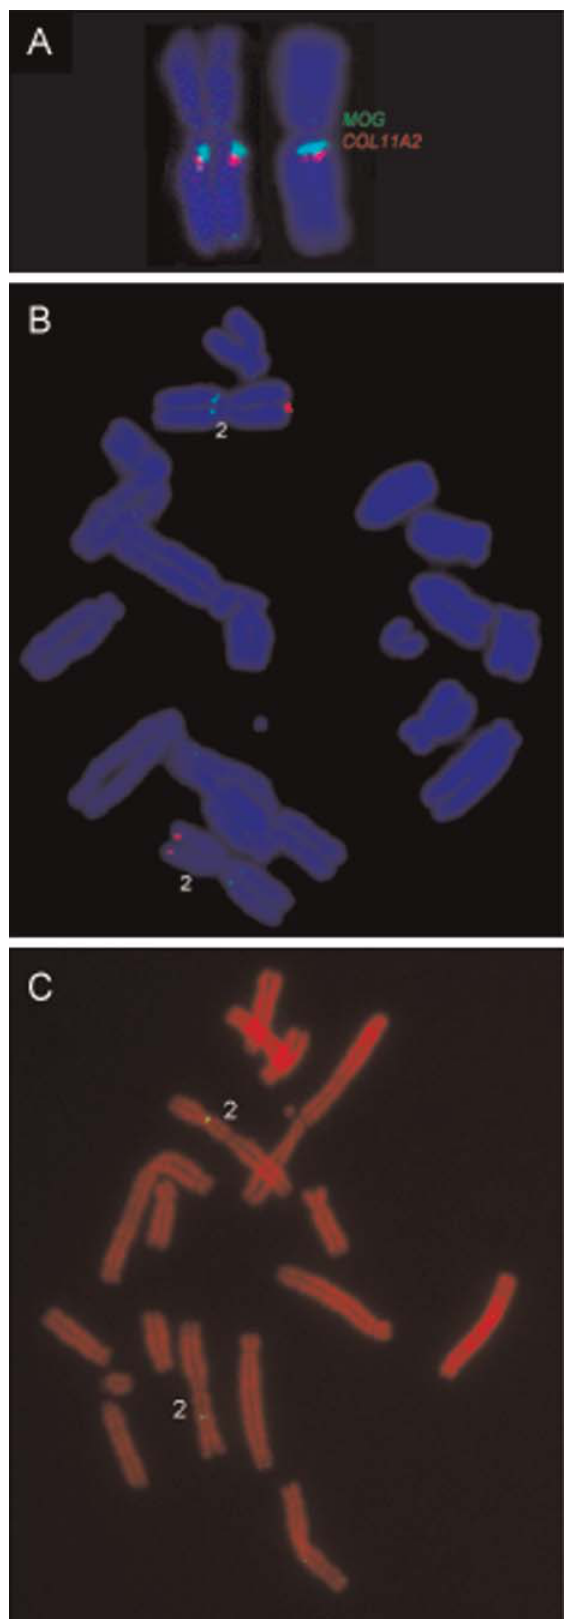
Figure 2. Fluorescence In Situ Hybridization of Opossum MHC- Containing BAC Clones on Opossum Metaphase Chromosomes (A) Co-localization of BACs containing MOG (162N8) (green) and COL11A2 (27I16) (red) to show the orientation of the main MHC region at the centromeric region of 2q. (B) Co-localization of MHC-linked Class I UG (323O1) BAC to the centromeric region of 2q (green) and putative non-classical Class I UB/ UC (253C16)–containing BAC to the telomeric region of 2p (red). (C) Localization of CD1 (969K11) to Chromosome 2p. DOI: